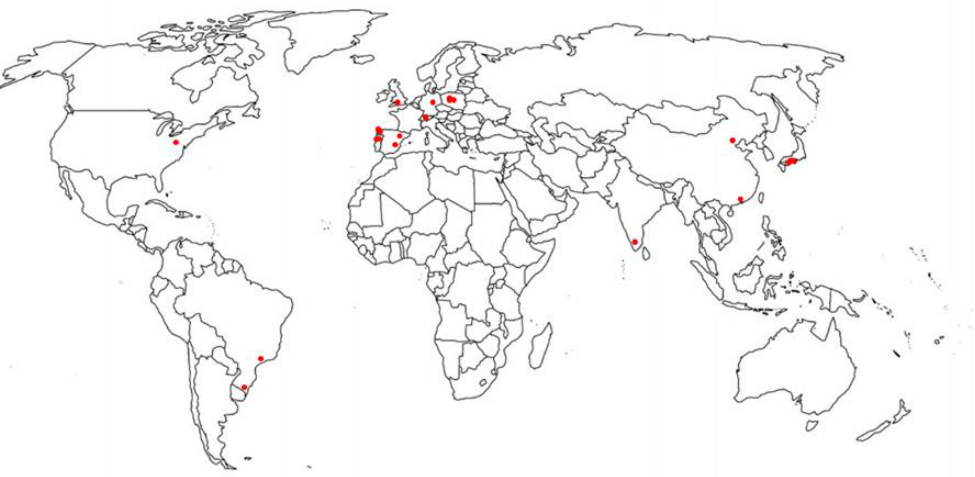
Figure 2. Geographic locations of parabens detected in water sources. Table 5. Paraben detected in several water sources.